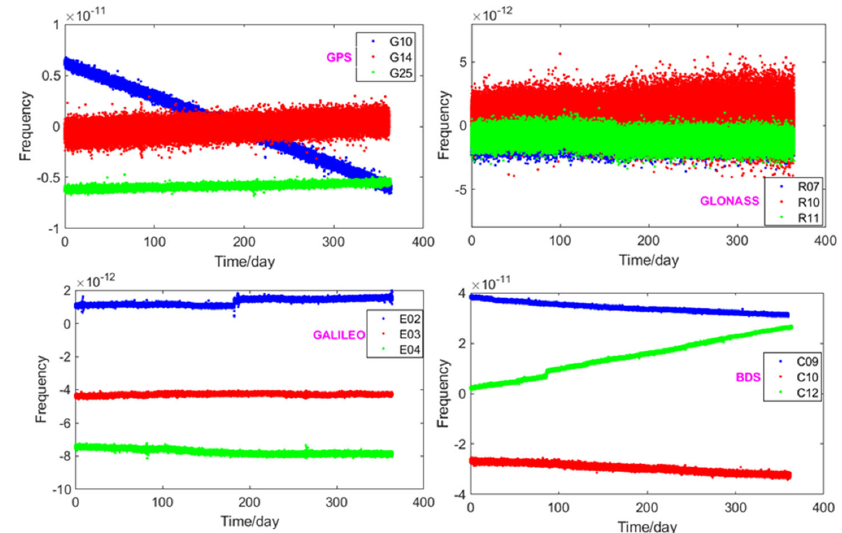
Figure 3. The frequency of GNSS satellites ( a ) GPS, ( b ) GLONASS, ( c ) GALILEO, ( d ) BDS. As shown in Figure 4, the stability of the BDS was consistent between satellites; it was approximately 10 − 13 at τ = 100 s and τ = 1000 s, while for 10,000 s and τ , it was one day ( τ = 86,400 s), and the result was in the order of 10 − 14 . For Galileo, it was 10 − 13 for an average